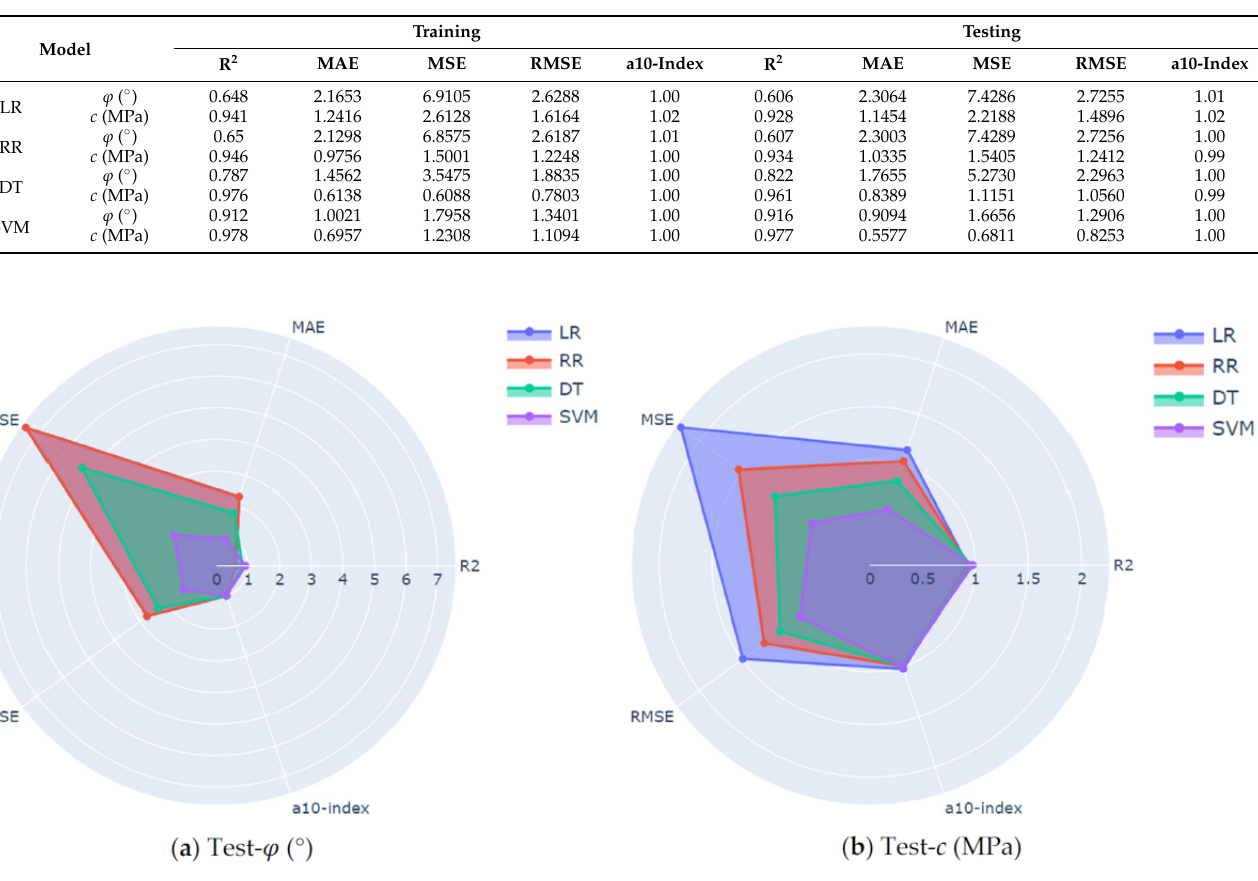
Table 3. Performance indices of ML-based developed models in this study.